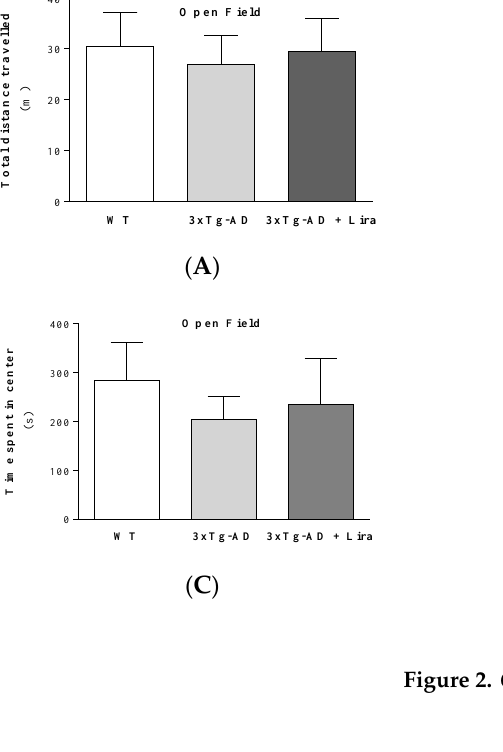
WT 3xTg-AD 3xTg-AD + Lira